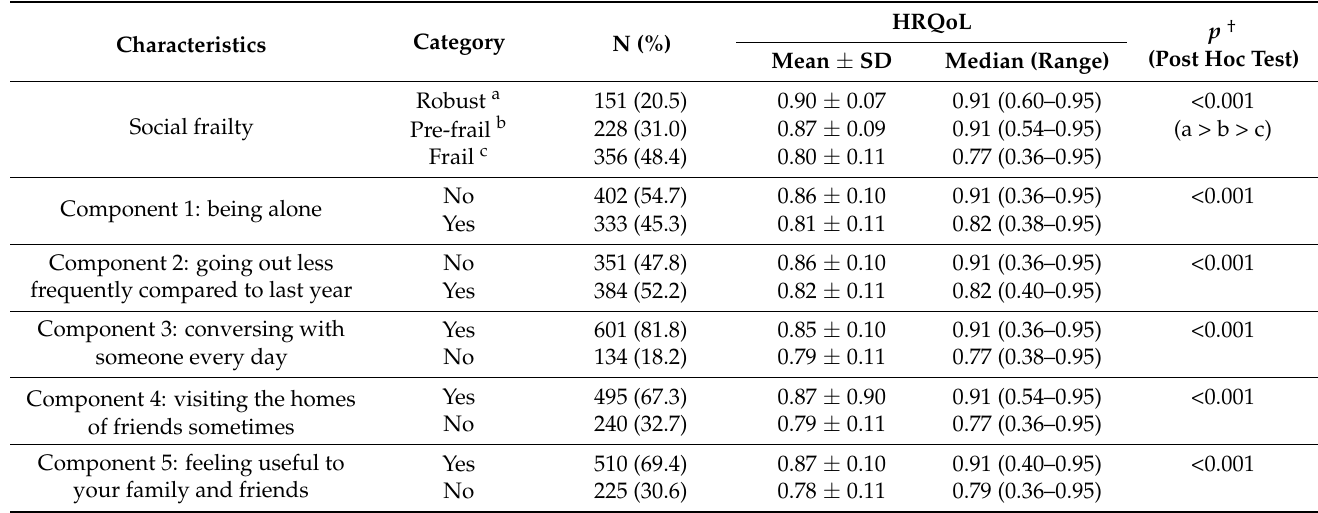
Table 2. Social frailty and health related quality of life; N = 735.